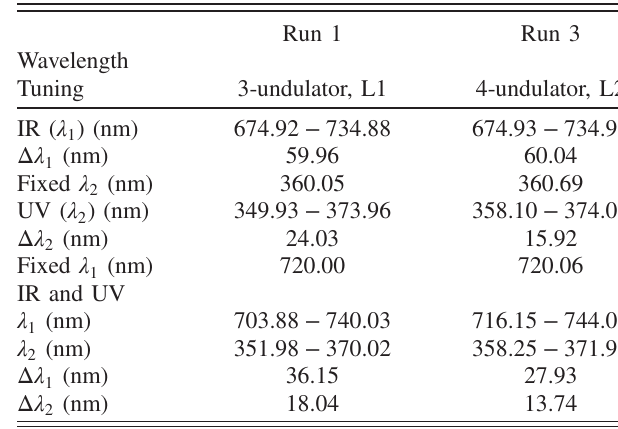
TABLE II. Summary and comparison of wavelength tuning ranges in two experimental runs with different undulator con- figurations, loss curves and beam currents. In Run 1, the three- undulator configuration and the relatively fresh FEL mirrors (loss curves L1) were used with the beam current ∼ 16 mA for the single wavelength tuning and ∼ 20 mA for the harmonic lasing tuning [47]. In Run 3, four undulators were employed with the usage of the degraded FEL mirrors (loss curves L2) and the beam current ∼ 12 mA for all the three sets of wavelength tuning measurements. The tuning ranges are shown in Fig. 2 with those of the single wavelength tuning enclosed by the dashed lines and those of the harmonic lasing represented by the shaded regions.